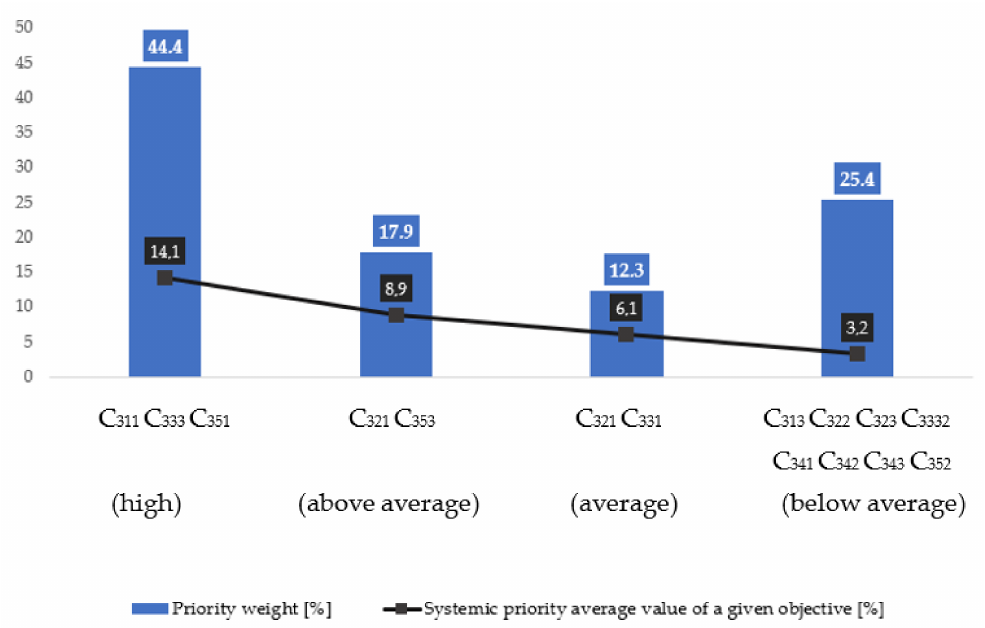
Figure 4. Hierarchy of importance of level III factors affecting the production of solar energy in small PV installations in Poland. The system priorities of level III factors were further divided into four ranges of significance (“weights”), that is: high, higher than average, average, and lower than average. Distinguishing of mentioned groups was based on the total range of system priorities with their average value of 5.0%. This approach led to the identification of the following ranges of importance: high (13.7–15.2%), higher than average (9.2–13.7%), average (4.6–9.1%), and lower